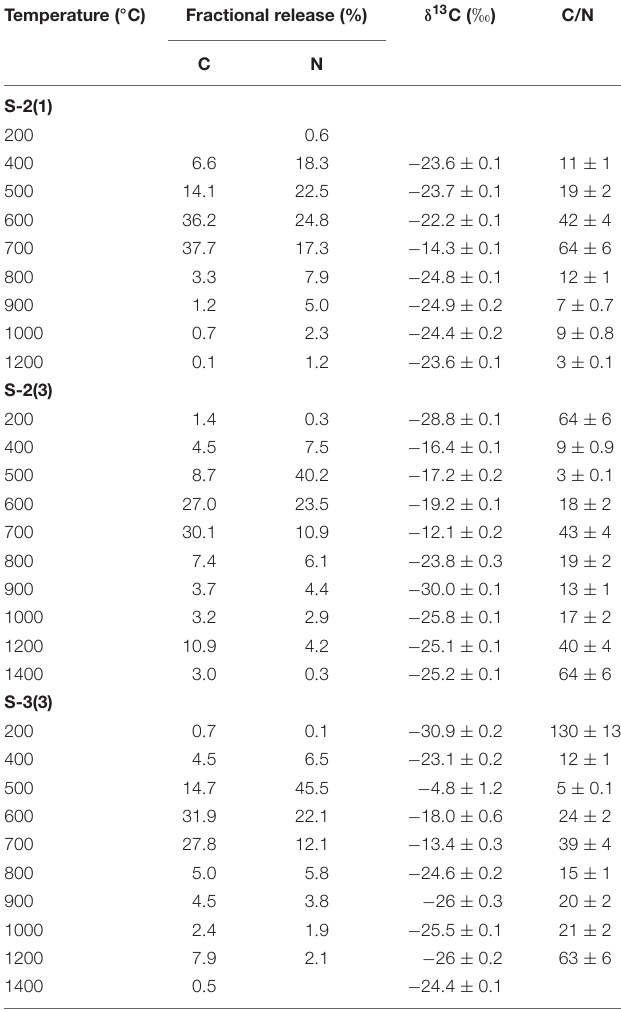
TABLE 3 | Individual step release of carbon (C) and nitrogen (N) from shale during combustion with corresponding δ 13 C and C/N ratios. Temperature ( ◦ C) Fractional release (%) δ 13 C (